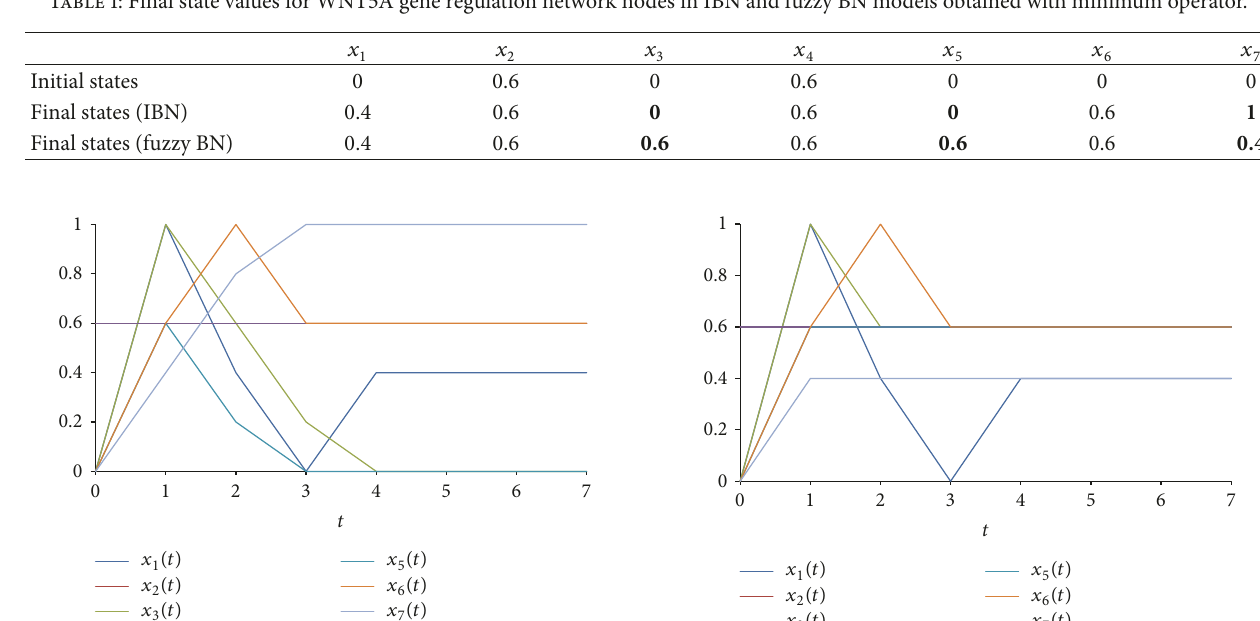
Table 1: Final state values for WNT5A gene regulation network nodes in IBN and fuzzy BN models obtained with minimum operator.